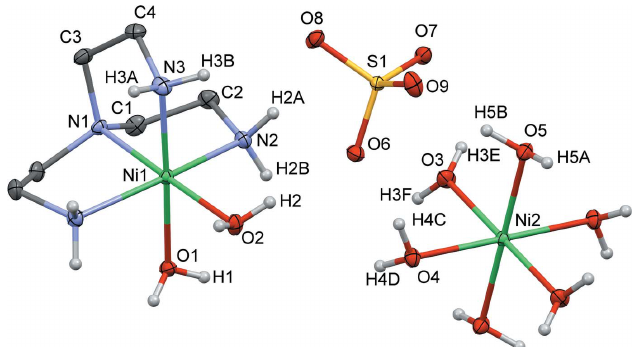
Figure 1 View of the molecular structure of the title compound with displacement ellipsoids drawn at the 20% probability level and labeling scheme for the symmetry-independent atoms. The CH 2 hydrogen atoms have been omitted for clarity. The symmetry operations generating the equivalent atoms are 1 (cid:2) x , 1 (cid:2) y , 2 (cid:2) z and x , 1 [Ni(tren)(H 2 O) 2 ] 2+ ,